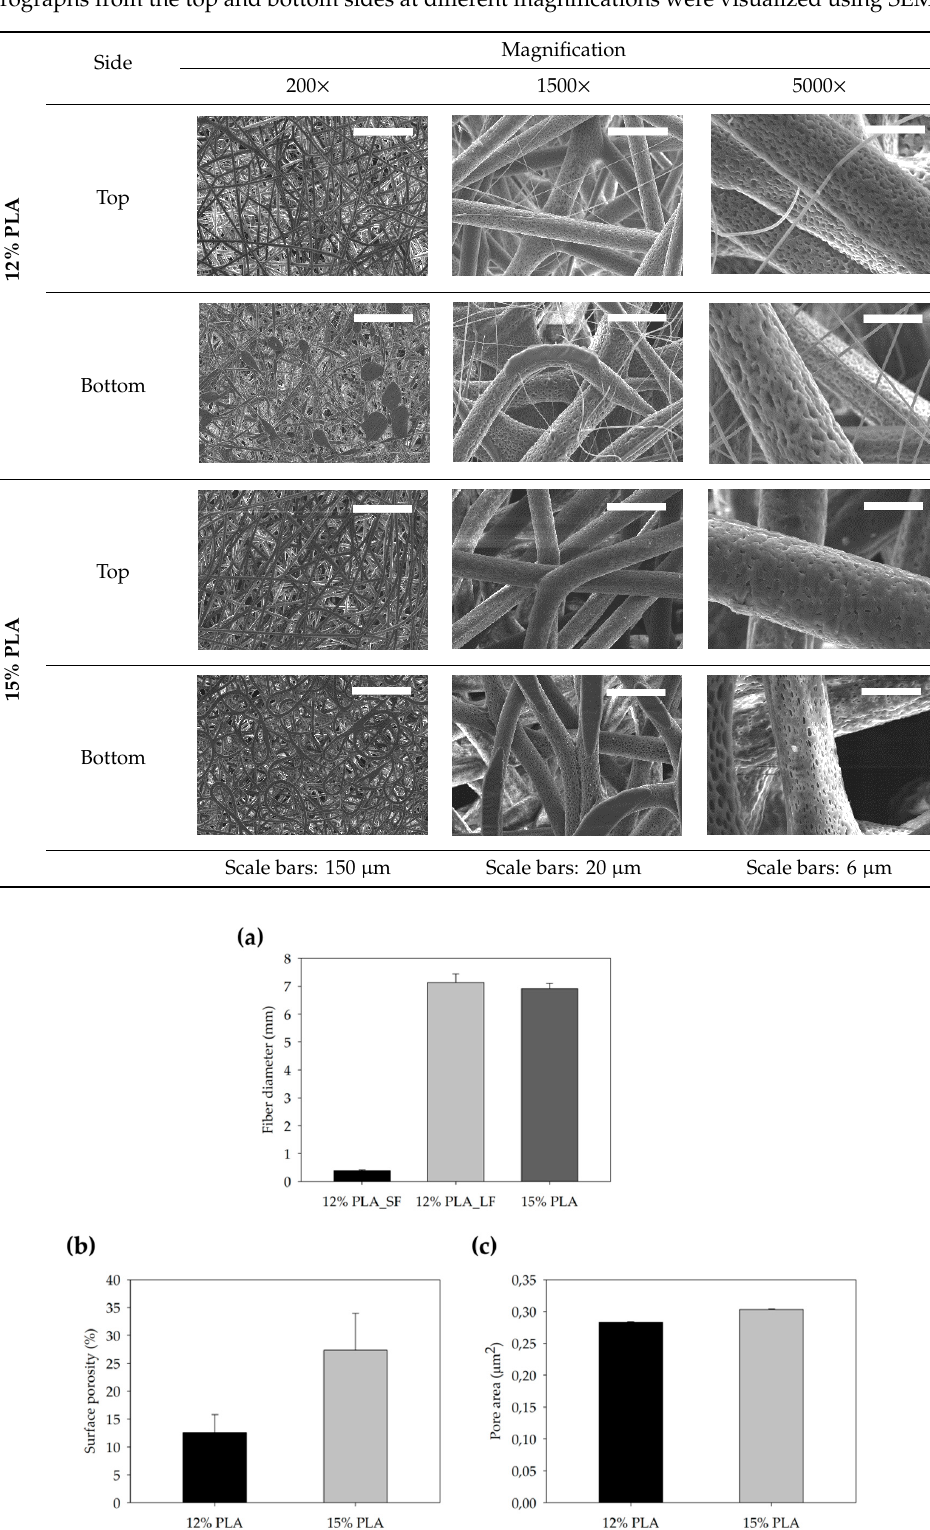
Figure 3. Features of 12% and 15% ES-PLA scaffolds. Images taken from the top and bottom sides were used to calculate ( a ) fiber diameter, ( b ) surface porosity, and ( c ) pore diameter. Results are shown as average ± SE. SF: small fibers; LF: large fibers.